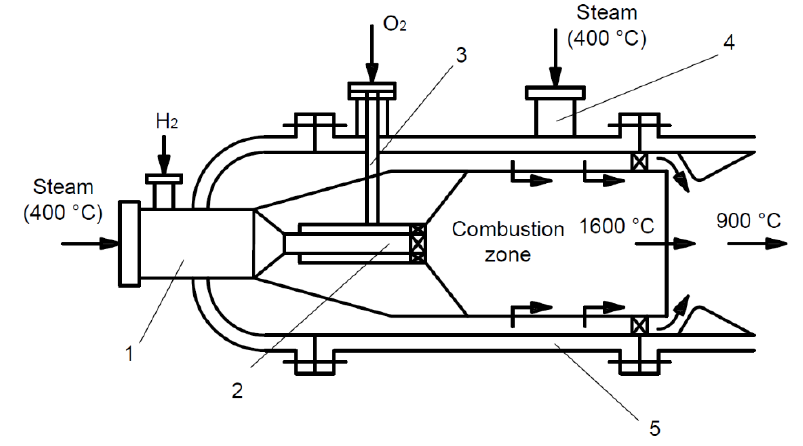
Figure 7. Combustion chamber using hydrogen fuel for steam overheating. At the inlet, there is a mixing chamber (1), where steam that is overheated to 400 °C and hydrogen are supplied. Then, this mixture is fed to the burner (2). The oxygen that is